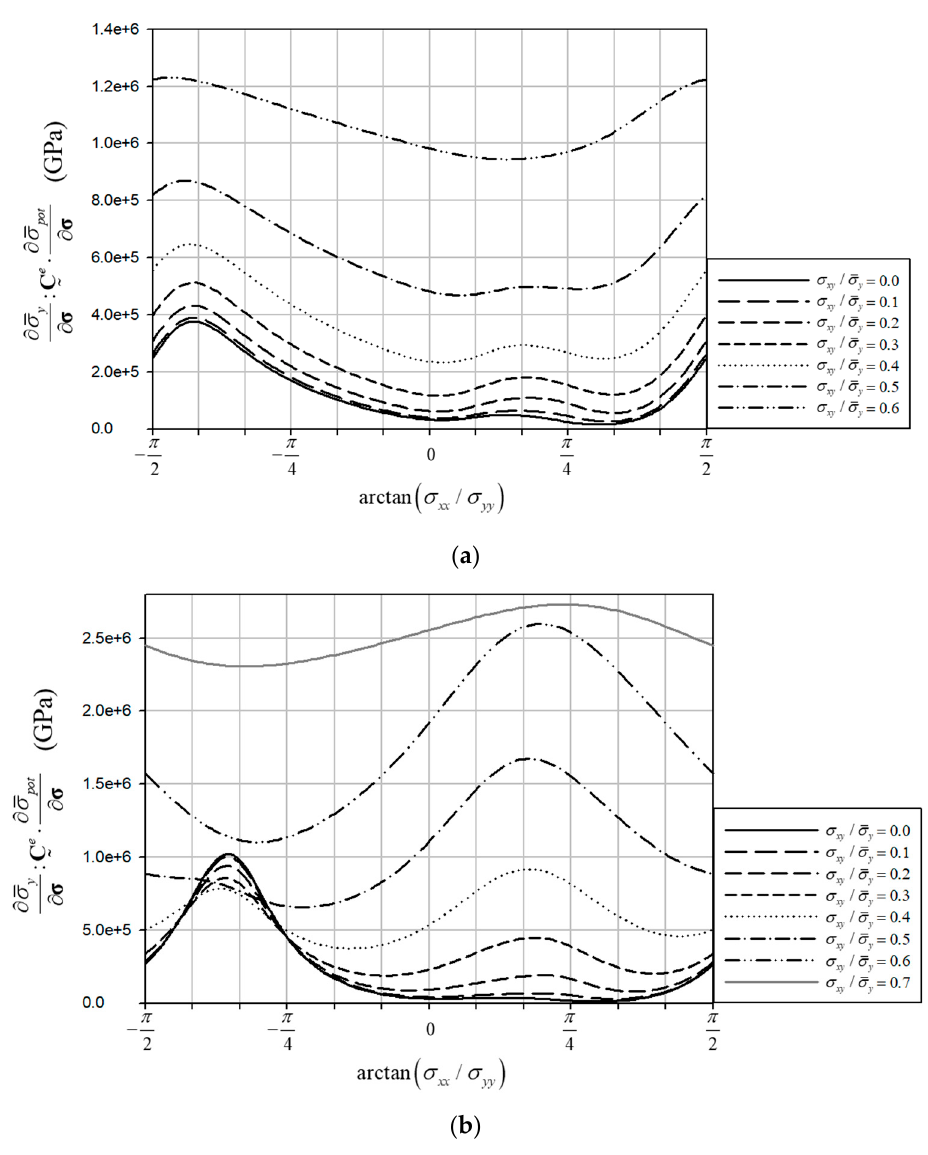
Figure 14. The tensor product of the gradients of the yield function and the plastic potential for the elastic stiffness tensor for the niobium sheet ( a ) at 0 MPa plastic work and ( b ) at 40 MPa plastic work.